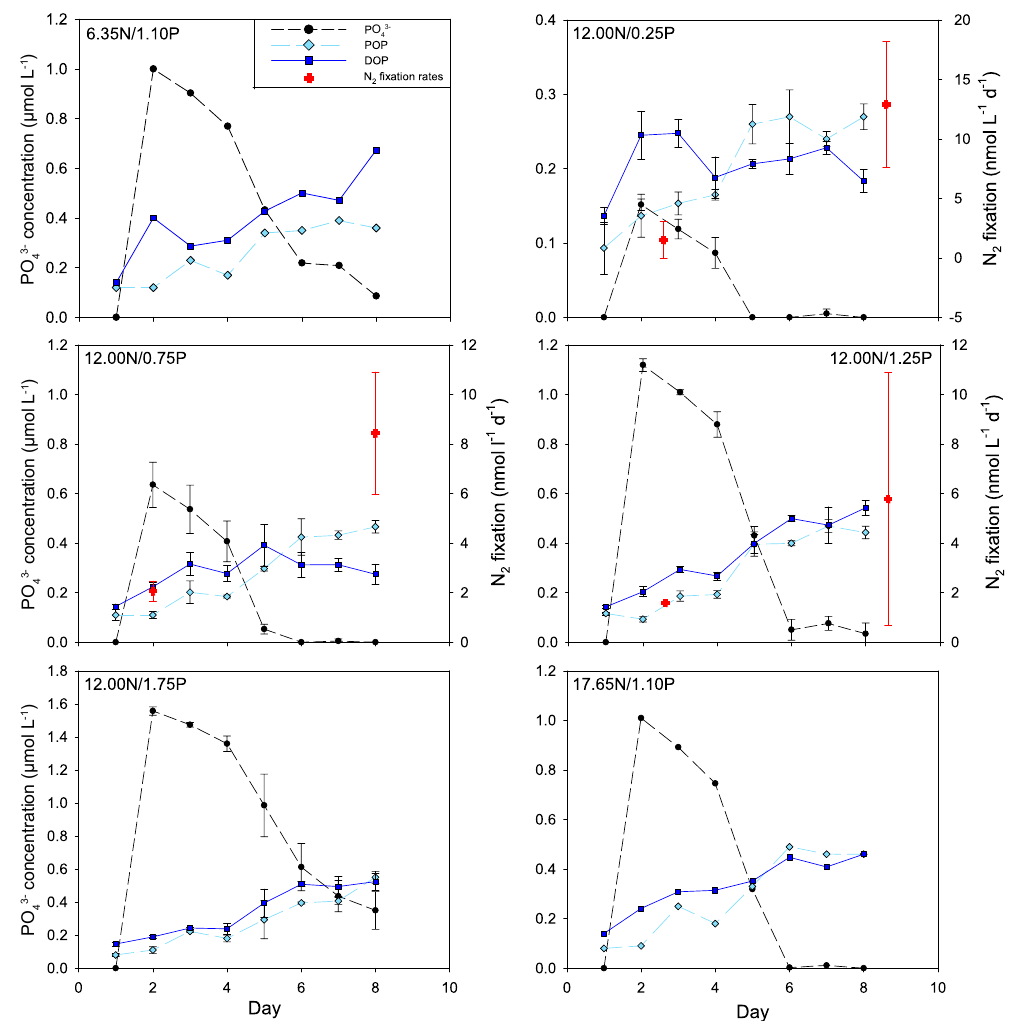
Figure 9. Dynamics of PO 3 − , POP and DOP and N 2 fixation rates in mesocosms during varied P . Because of the high variance between 4 replicates we omitted N 2 fixation rates from un-replicated